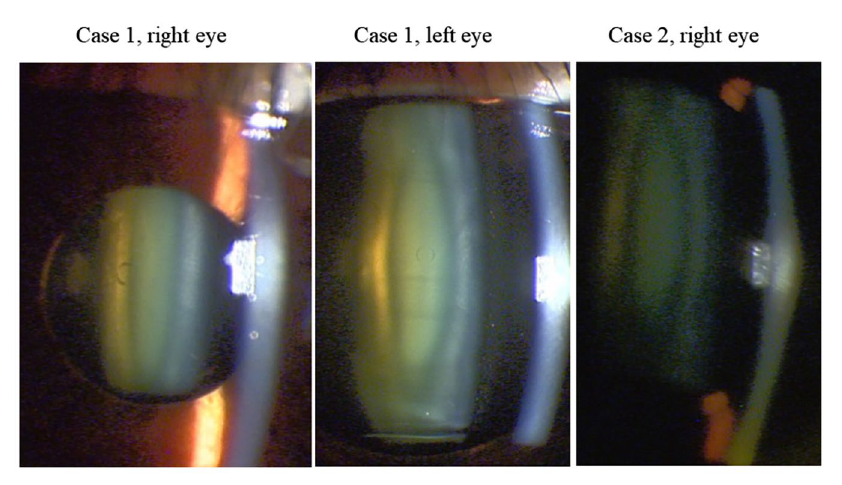
Figure 3. Nuclear cataract cases after hole implantable collamer lens (ICL) implantation.